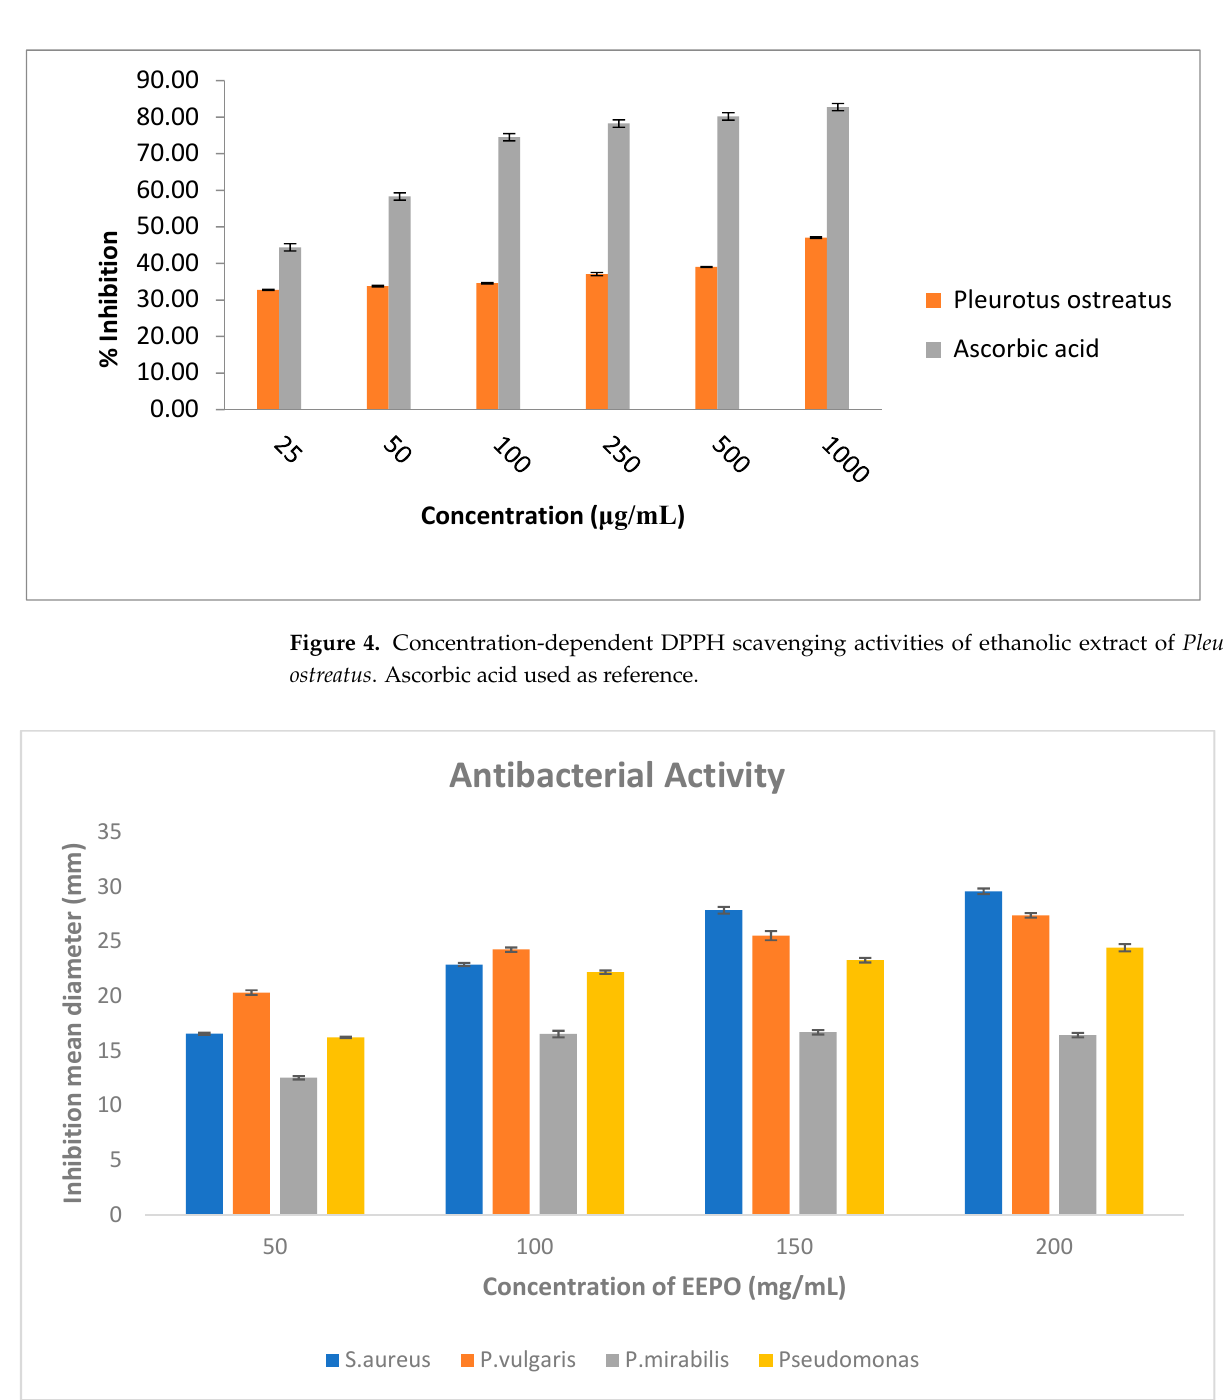
Figure 5. The agar well diffusion method was employed to determine the antibacterial activity of EEPO of various concentrations (50, 100, 150 and 200 mg/mL), and the averages of zones of inhibition in millimeters (mm) against Gram-positive and Gram-negative bacteria are graphically shown. Values are represented as mean ± SD.